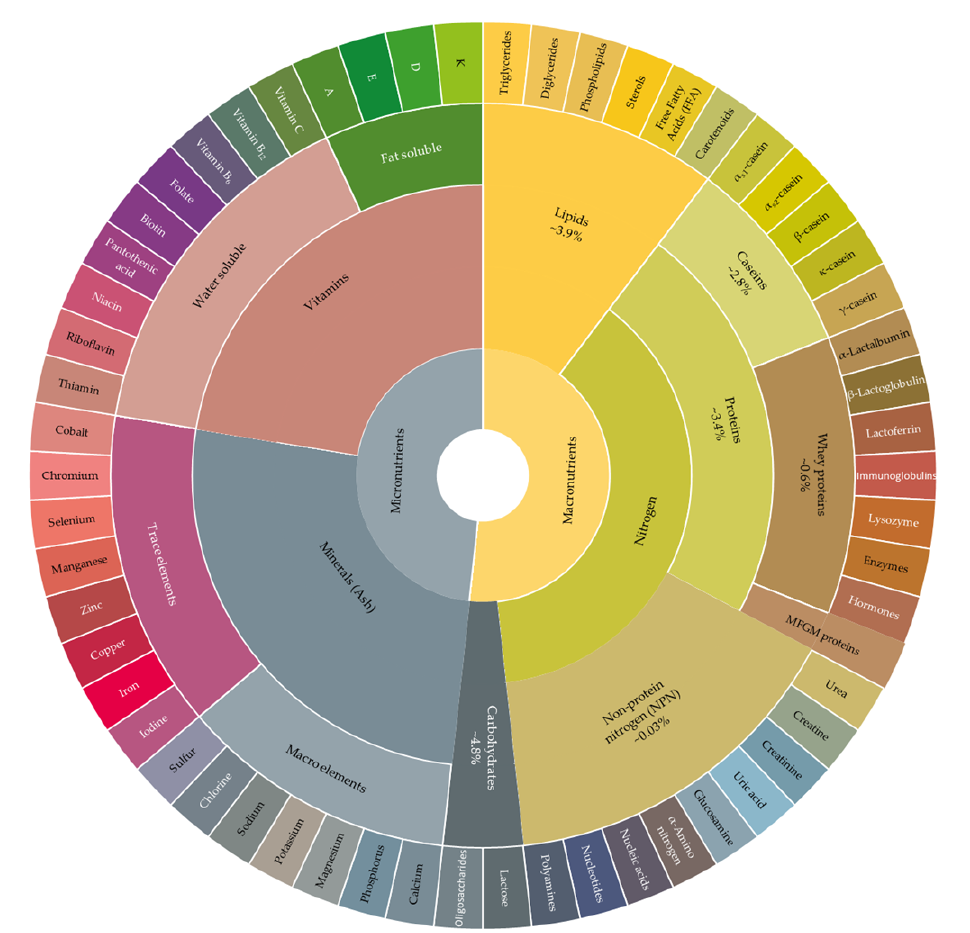
Figure 1. Bovine milk composition wheel. Sections are not proportionate to the actual content of each component in milk. Concentrations of these components in milk are provided in Table